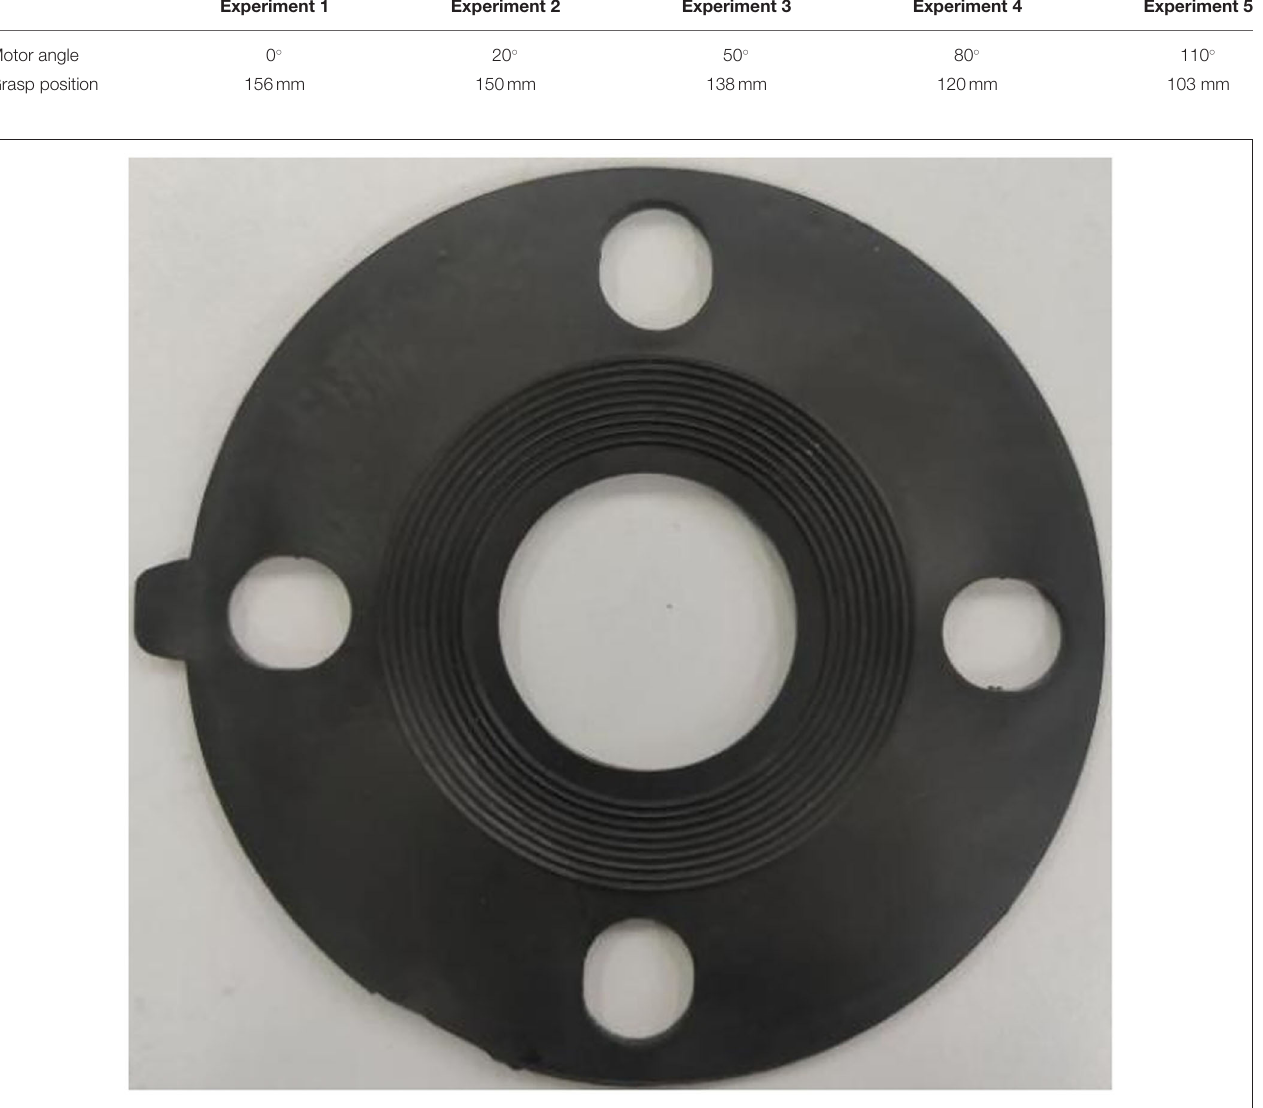
FIGURE 5 | Physical drawing of rubber